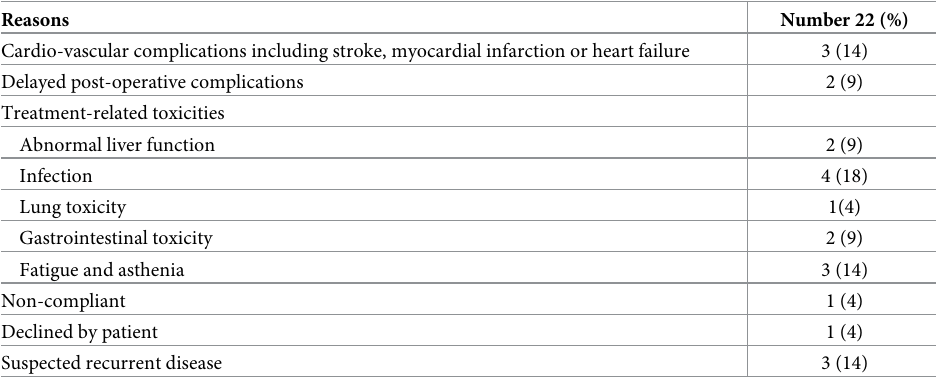
Table 3. The reasons of early discontinuation of adjuvant